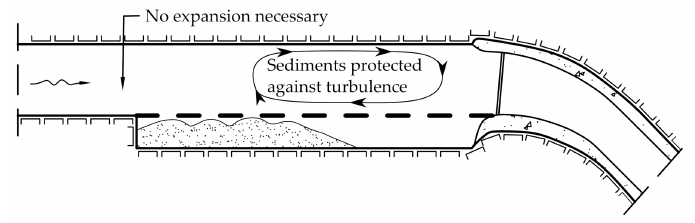
Figure 7. Advantages with closed rock